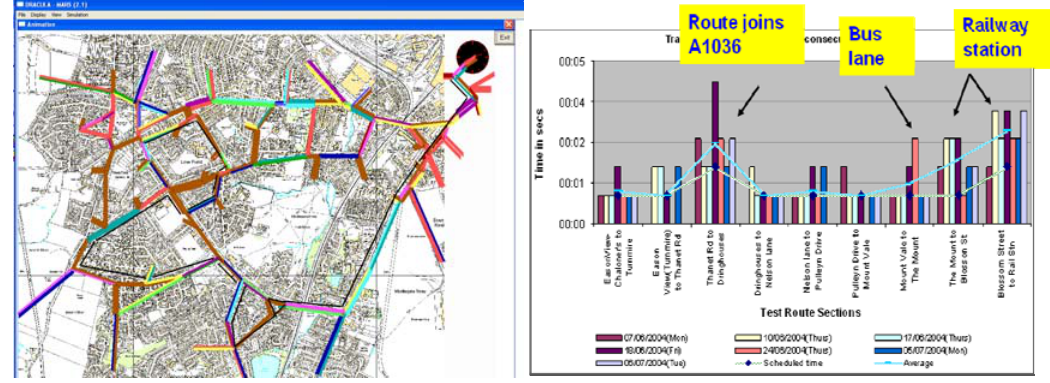
Figure 5a. York study area Figure 5b. Typical calibration outputs